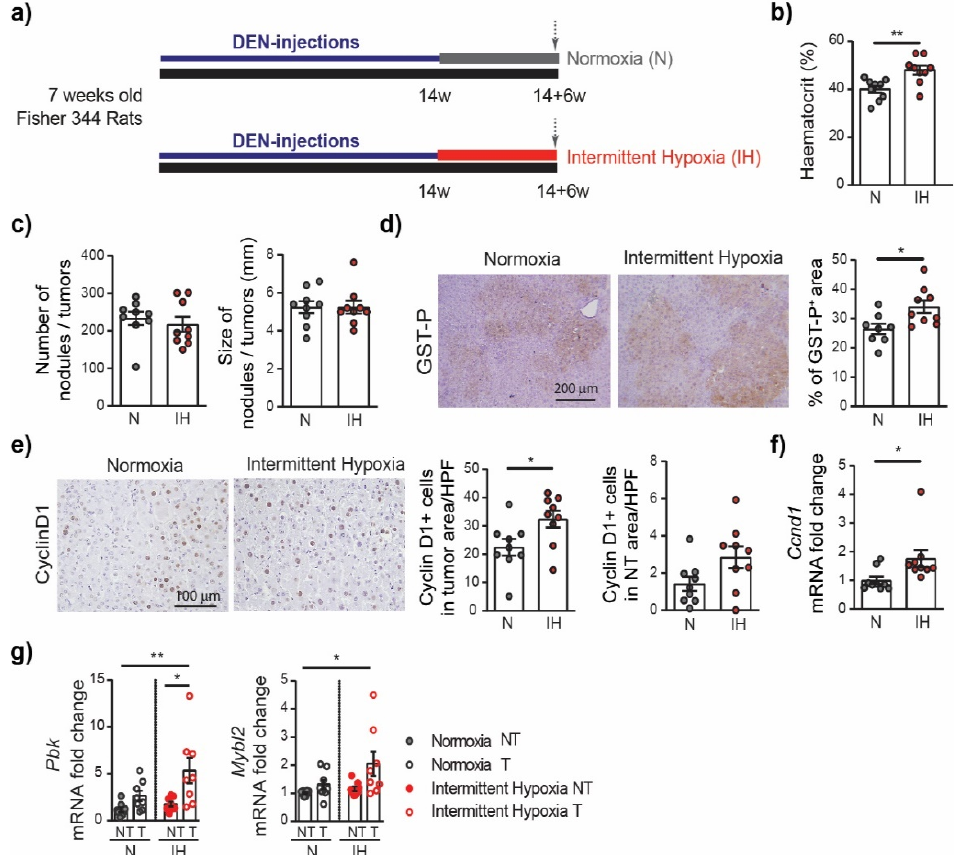
Figure 2. Intermittent hypoxia increases cell proliferation in chronic DEN-induced HCC. ( a ) Timeline protocol of the intermittent hypoxia experiment. Seven-week-old Fisher 344 rats were injected weekly by DEN (50 mg/kg per week) during 14 weeks and then subjected to either normoxia or intermittent hypoxia during 6 weeks. The arrows indicate the day of tissue harvest. ( b ) Effect of chronic intermittent hypoxia on the haematocrit (the volume percentage (%) of red blood cells in the blood of rats). ( c ) Macroscopic examination of livers with the assessment of the tumor number at the surface of livers and the tumor size (average of the diameter of the five largest tumors). ( d ) Representative images of GST-P staining (10× magnification) and quantification of GST-P+ surface area per high power field (HPF). ( e ) Representative images of nuclear Cyclin D1 staining (20× magnification) and quantification of nuclear Cyclin D1 positive hepatocytes per tumor area or per non tumoral area per HPF. ( f ) qPCR analysis of Cyclin D1 gene Ccnd1 expression in the liver samples. Each circle represents an individual animal, mean ± SE, n = 9/group. The comparison of the means was performed by an unpaired t -test. ( g ) The impact of intermittent hypoxia on cell proliferation and cell cycle progression, as determined by the gene expression of PDZ binding kinase (Pbk) and MYB proto-oncogene like 2 (Mybl2). NT—non-tumor tissue, T—tumoral tissue, n = 8–9/group. The comparison of the means was performed by ANOVA with the Tukey HSD correction for multiple means comparisons, * p < 0.05, ** p < 0.01.